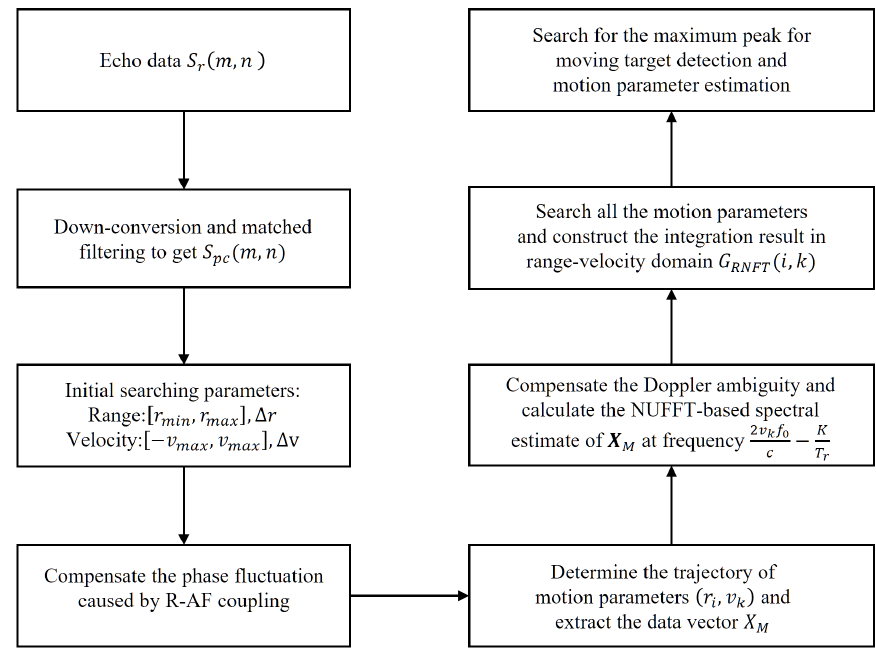
Figure 2. Flow chart of the proposed method.